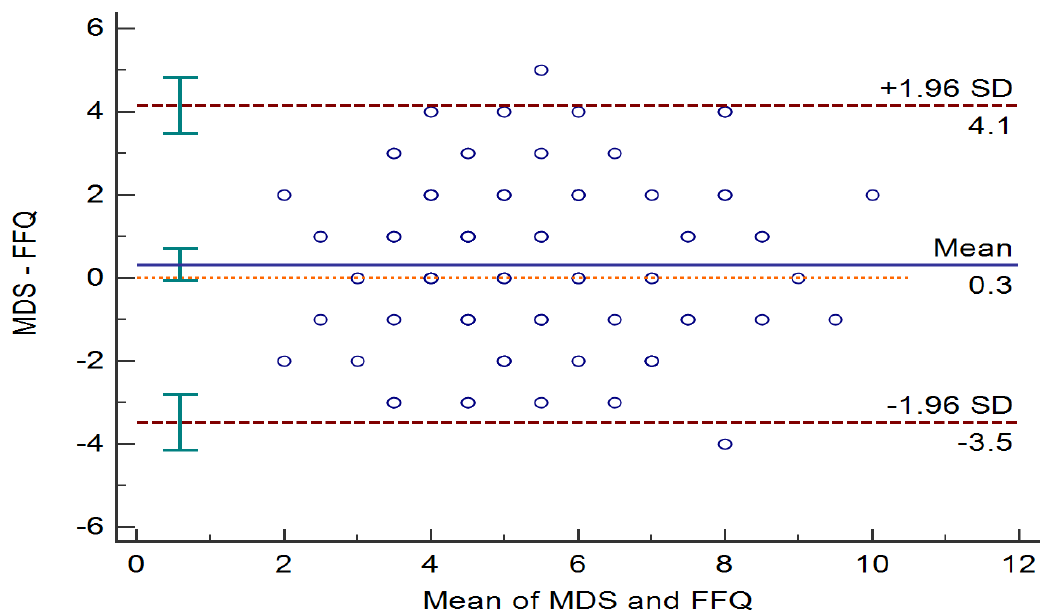
Figure 1. Bland–Altman plots showing the differences between the Korean version of the Mediterranean Diet Adherence Screener score and the food frequency questionnaire score.